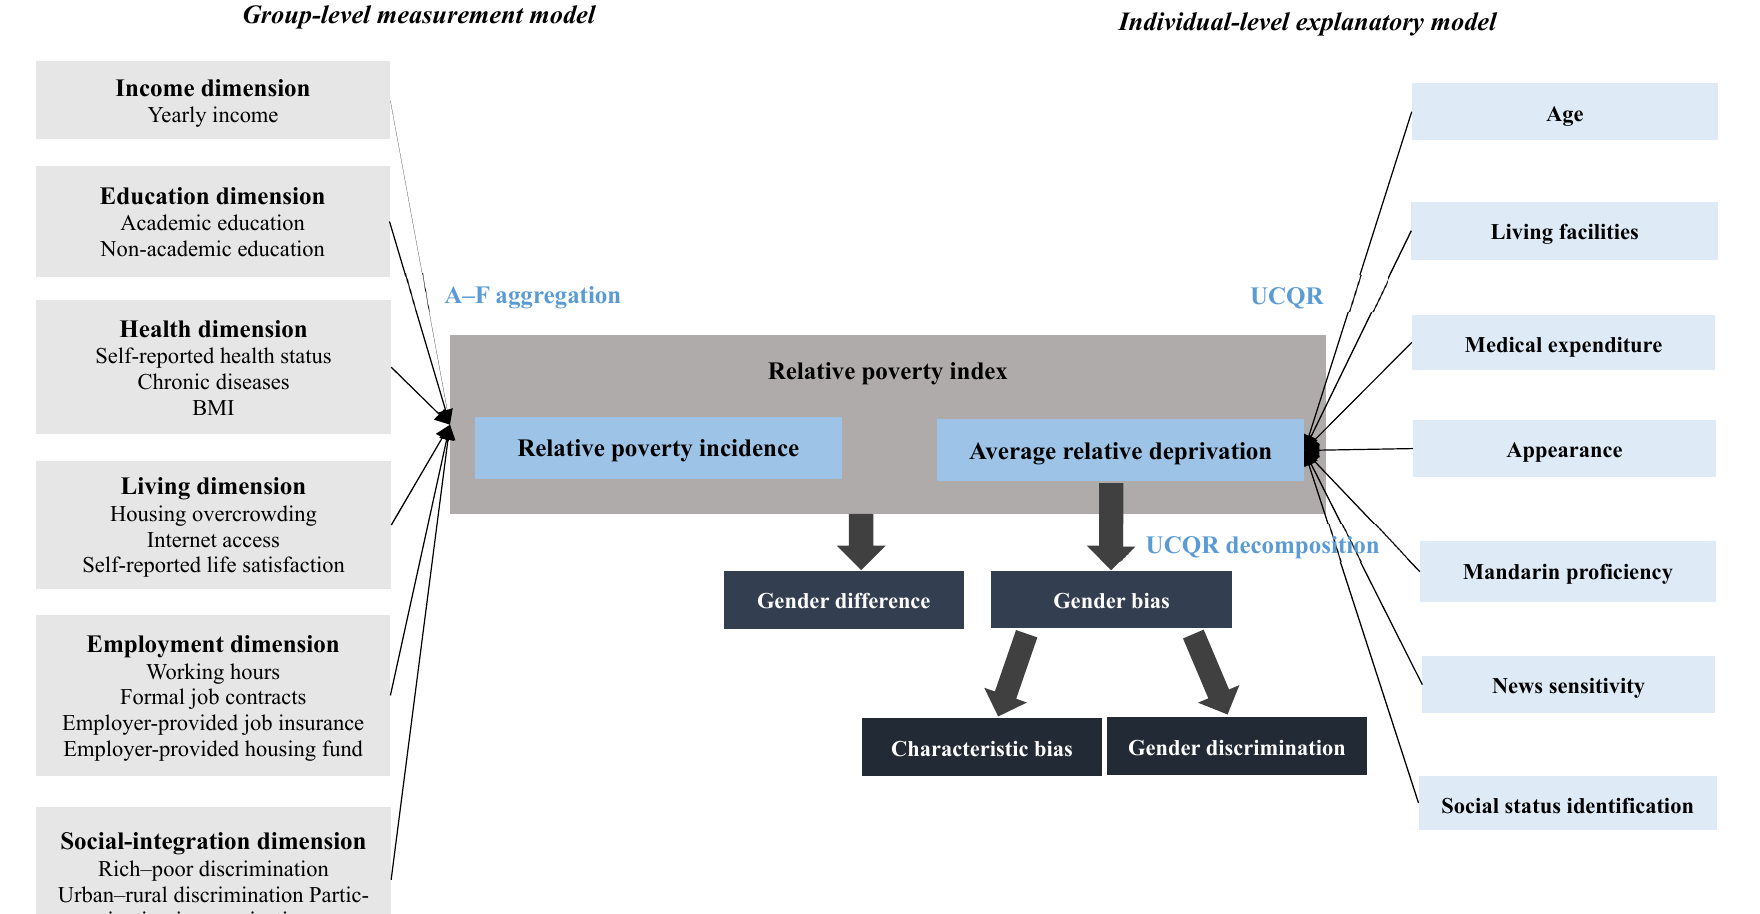
Figure A1. Overall research design.